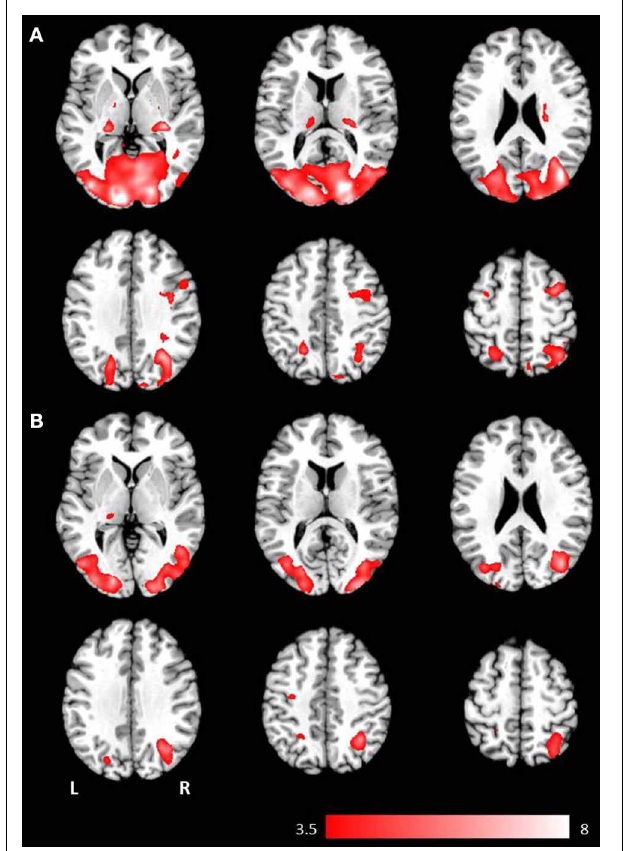
FIGURE 1 | Axial mean anatomical images overlaid with brain activation resulting from second-level GLM analysis, revealing higher brain activity for visual presentation compared to auditory presentation ( p < 0 . 001, uncorrected) induced by (A) the phrases task and (B) the verb generation